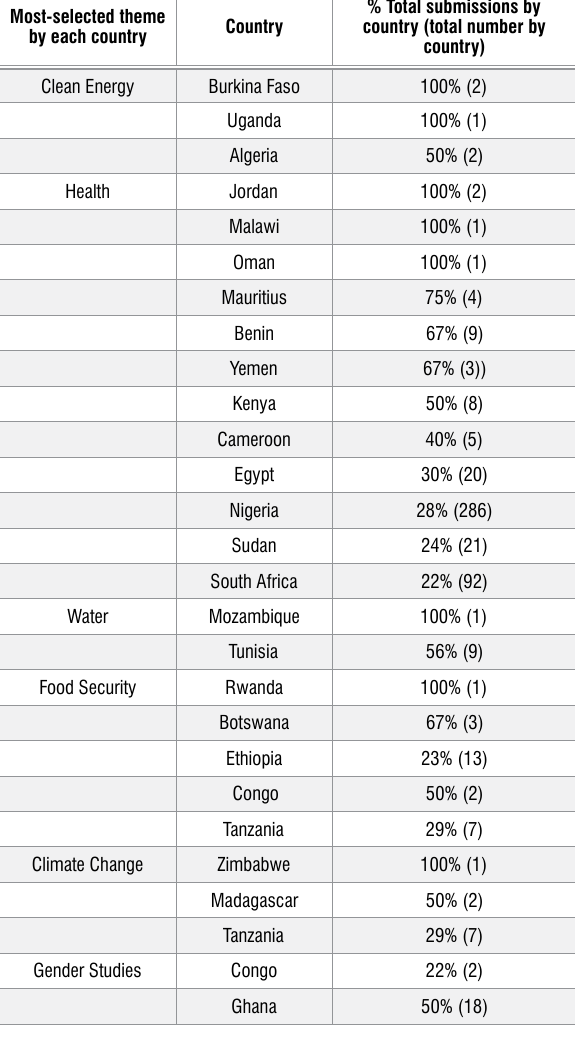
Theme with the highest number of submissions for each country Most-selected theme Country by each country